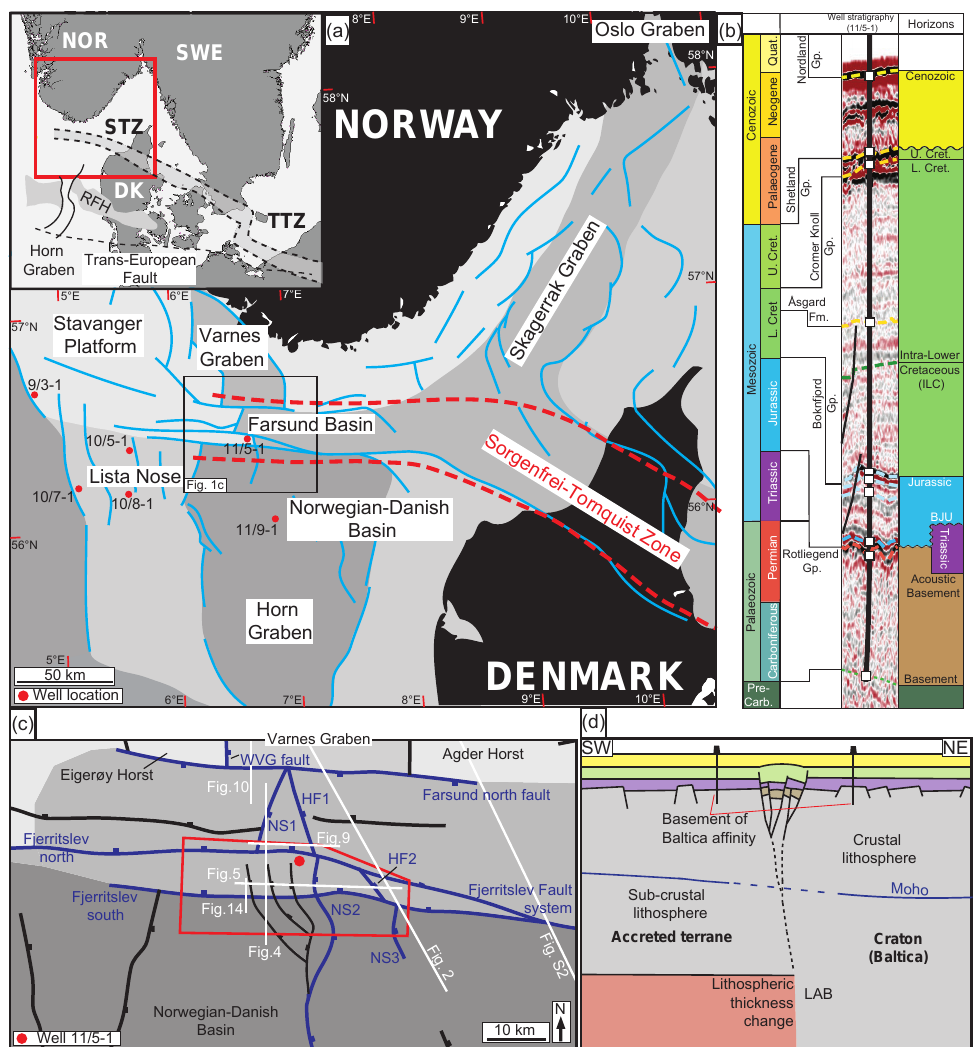
Figure 1. (a) Regional map of the study area showing the relation to the major structural elements and fault networks. Faults are based on interpretations made in this study with regional faults and the names of structural elements based on the Norwegian Petroleum Directorate (NPD) database. Well locations used to constrain ages of stratigraphic horizons are shown in red. Inset: regional map of the area showing the location and geometry of the Tornquist Zone. TTZ – Teisseyre-Tornquist Zone, STZ – Sorgenfrei–Tornquist Zone, RFH – Ringkøbing–Fyn High. (b) Stratigraphic column showing the stratigraphy encountered in well 11/5-1 (located within the 3-D volume) and the major tectonic events to have affected the region. (c) Map showing the fault networks present across the Farsund Basin (those referred to in the text shown in blue), the location of the 3-D seismic volume and the main figures used throughout the study. (d) Schematic cross-section, based on a NE–SW- to N–S-oriented section across the Sorgenfrei–Tornquist Zone, showing the Sorgenfrei–Tornquist Zone as defined at both upper- and sub-crustal depths, and the potential relationship between the